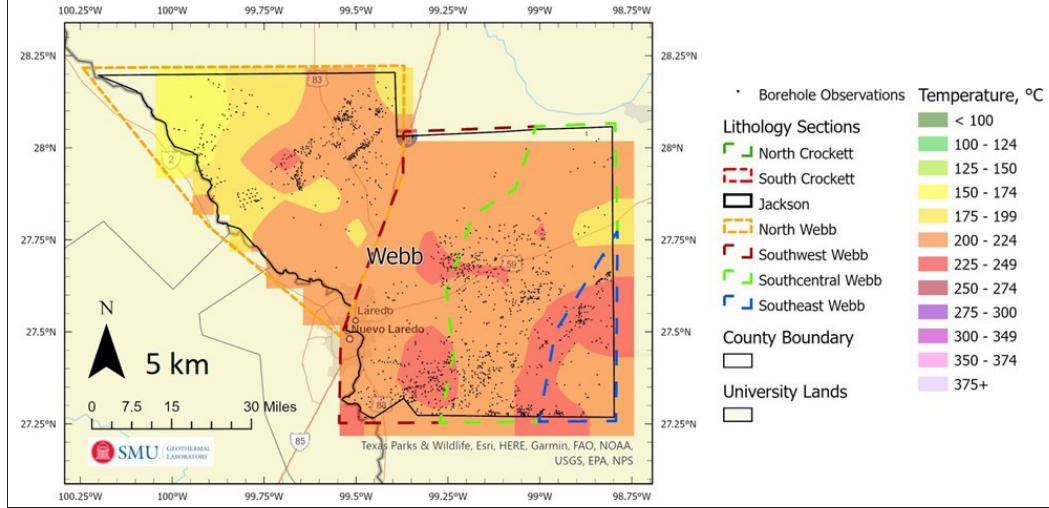
Figure 12. Temperature at 5.0 kilometers (km; 16,400 feet) depth in Webb County. Data point locations displayed as black dots. While all the data locations are shown, only two sites are below 5 km and both are above 200 °C